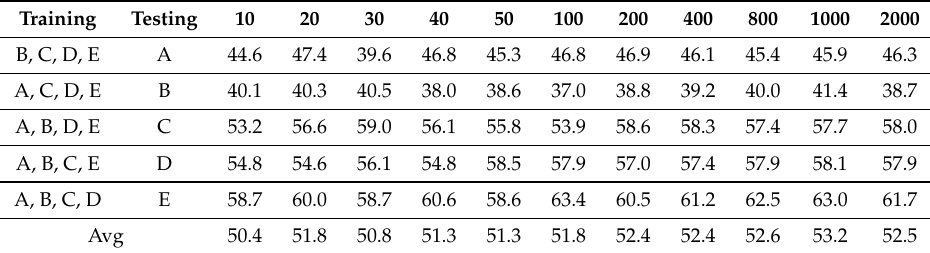
Table 10. Ens Bag performance for a different number of